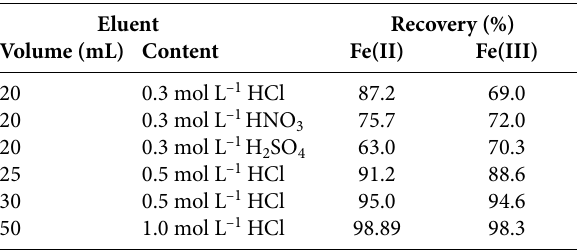
Table 2. Effect of concentration and type of eluent on the recovery of Fe(II) and Fe(III) ions.